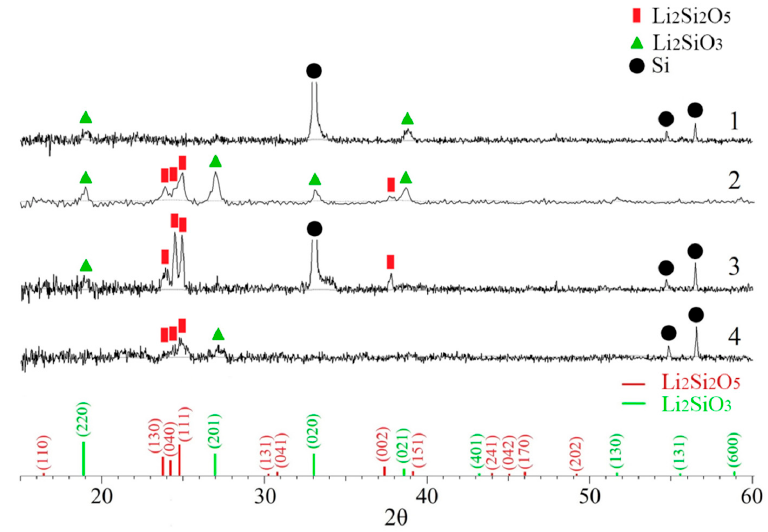
Figure 4. G razing incidence XRD of LNO-1/10 -1), LNO-1/3 -2), LNO-1/2 -3), and LNO-1/1 -4) Figure 4. Grazing incidence XRD of LNO-1 / 10 (1), LNO-1 / 3 (2), LNO-1 / 2 (3), and LNO-1 / 1 (4) annealed annealed at 800 °C for 15 min. at 800 ◦ C for 15 min.